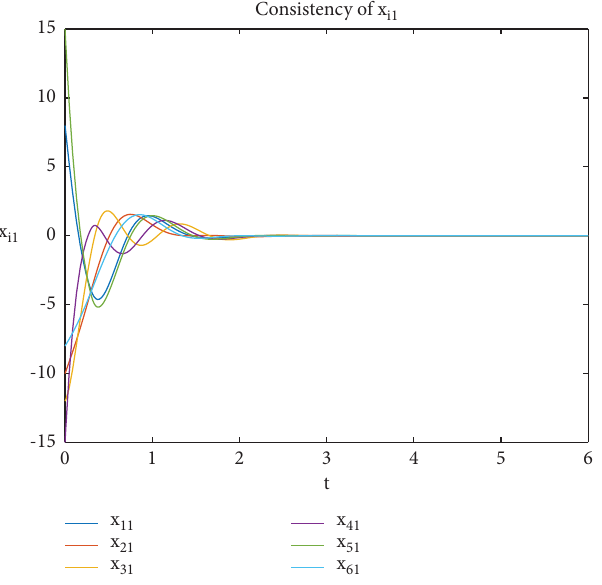
Figure 1: Te evolution of states x